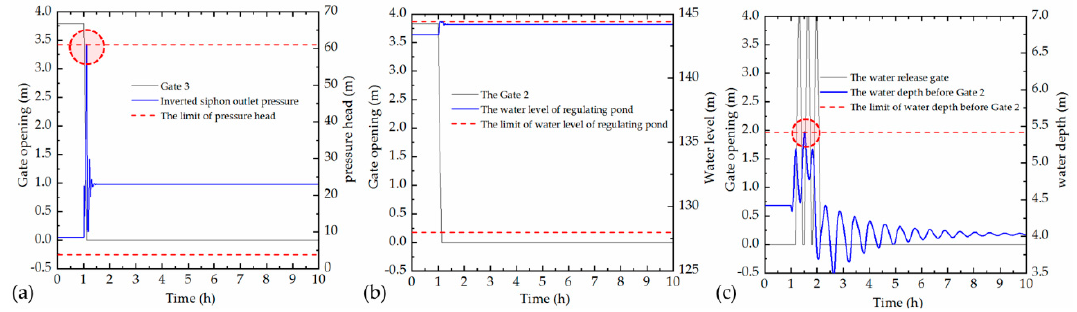
Figure 11. The simulation result of Scenario D-1 without MPC-1: ( a – c ) are same with Figure